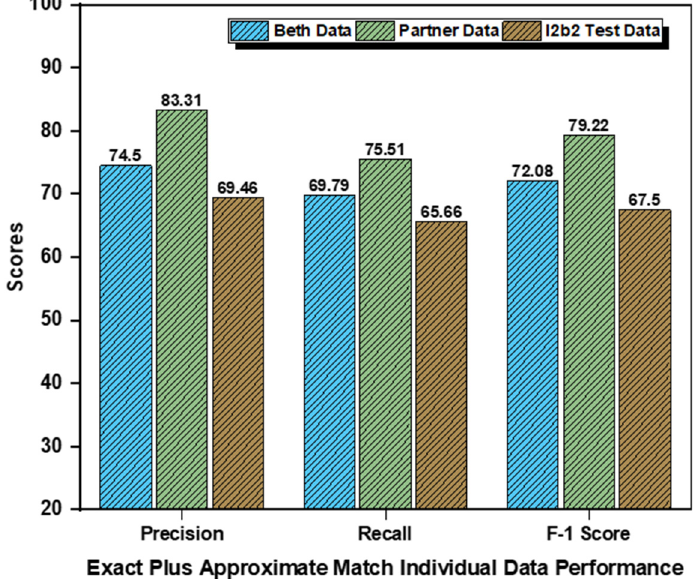
Figure A3. Individual dataset performances, employing exact and approximate term matching to UMLS.